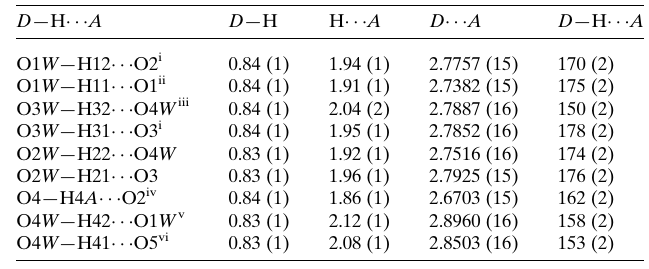
Table 1 Hydrogen-bond geometry (A˚ , (cid:3) ) for